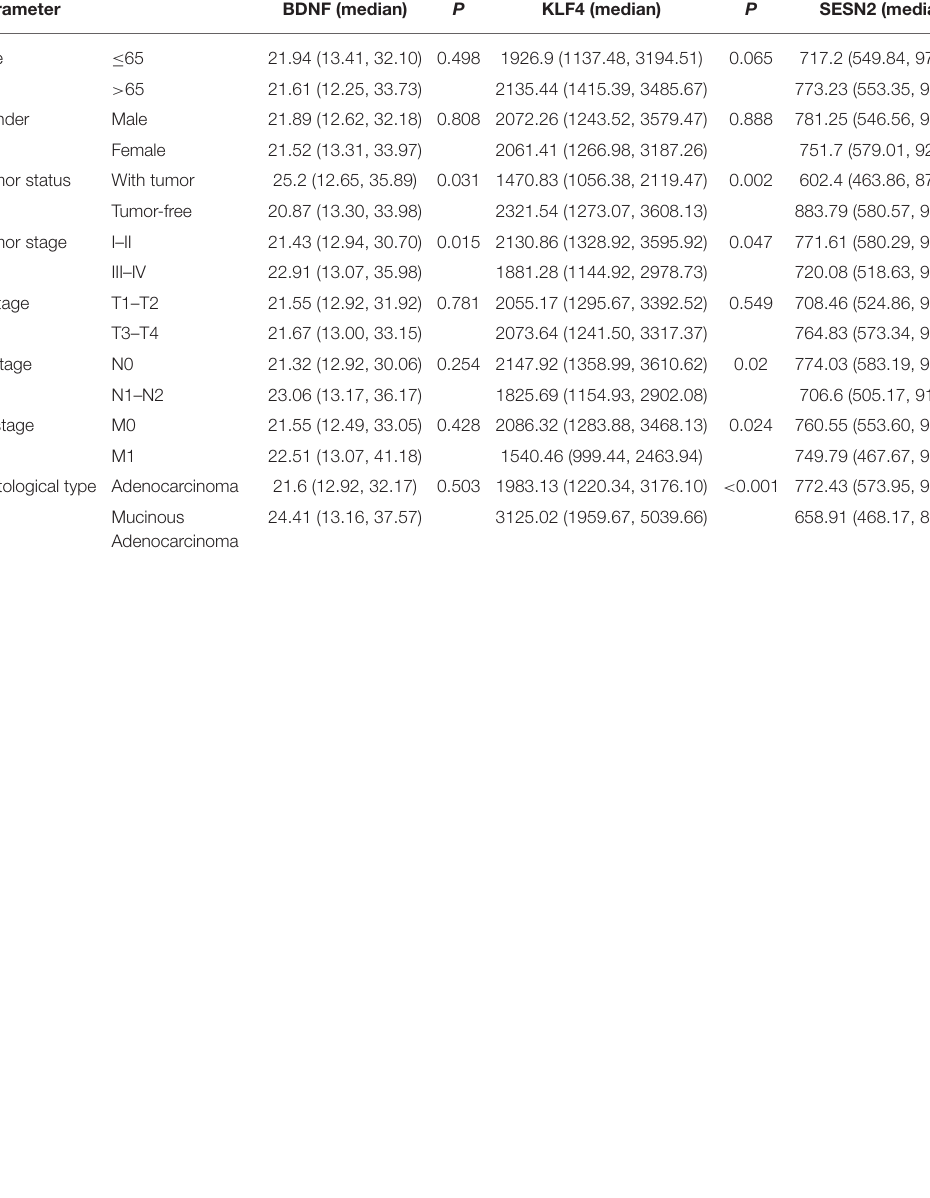
TABLE 3 | Relationships between the expression of five mRNAs and clinical parameters in the TCGA.